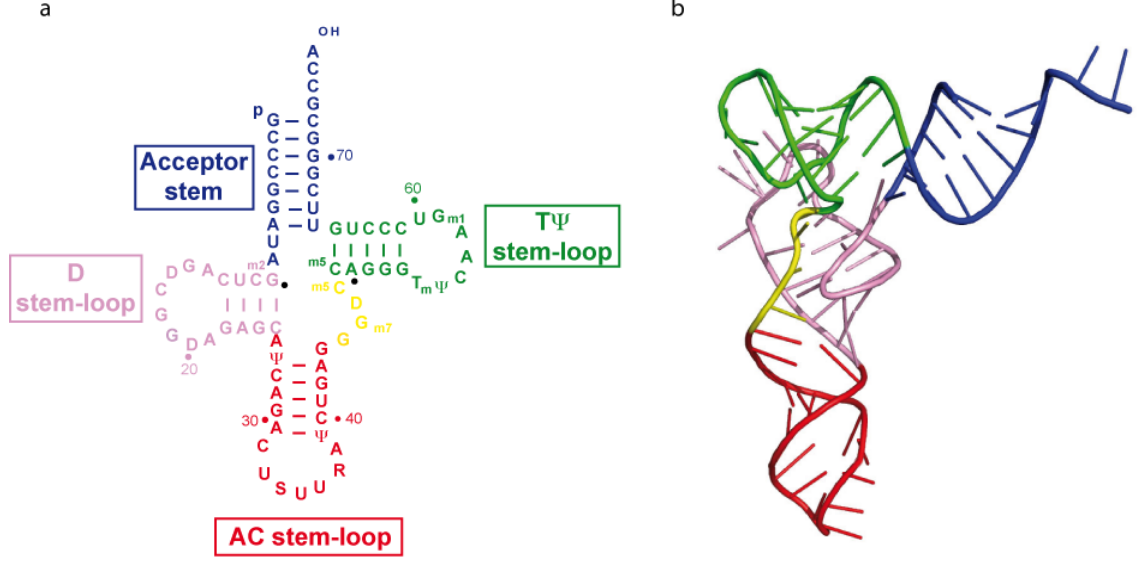
Figure 1 . Secondary (a) and tertiary (b) structures of tRNA 3Lys